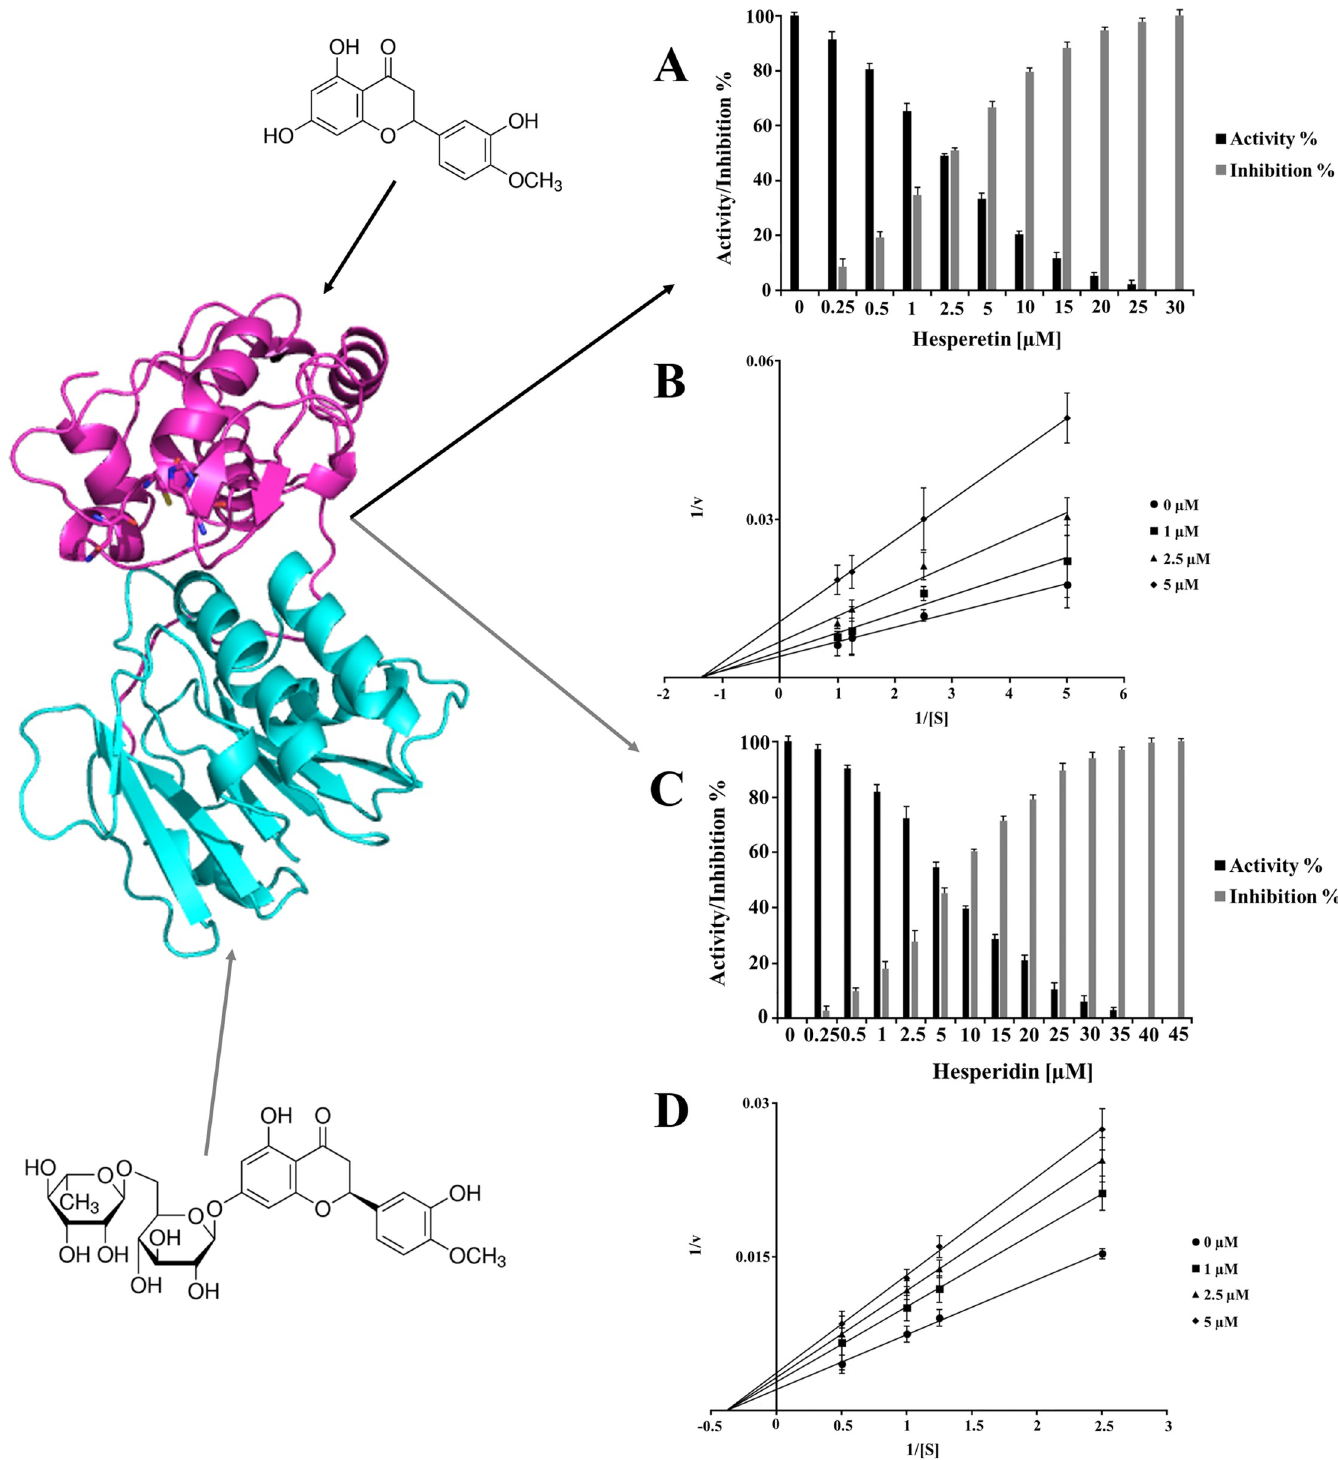
Fig 4. Inhibition effect and inhibition mode of HST and HSD on CHIKV nsP2 pro . Chemical structures of HST and HSD (structural formula) and CHIKV nsP2 pro 3D experimental model (PDB code: 3TRK) are shown. CHIKV nsP2 protease domain is presented in pink and the methyltransferase domain in cyan. Normalized activity and inhibition of the virus protease and Lineweaver-Burk plots to determine the inhibition mode is presented: [S] is the substrate concentration; v is the initial reaction rate. The data shown are the means ± SD from three independent measurements (n = 3). A and C: Normalized activity and inhibition of CHIKV nsP2 pro under HST and HSD influence, respectively. B and D: Lineweaver-Burk plot for HST and HSD inhibition of CHIKV nsP2 pro , respectively.